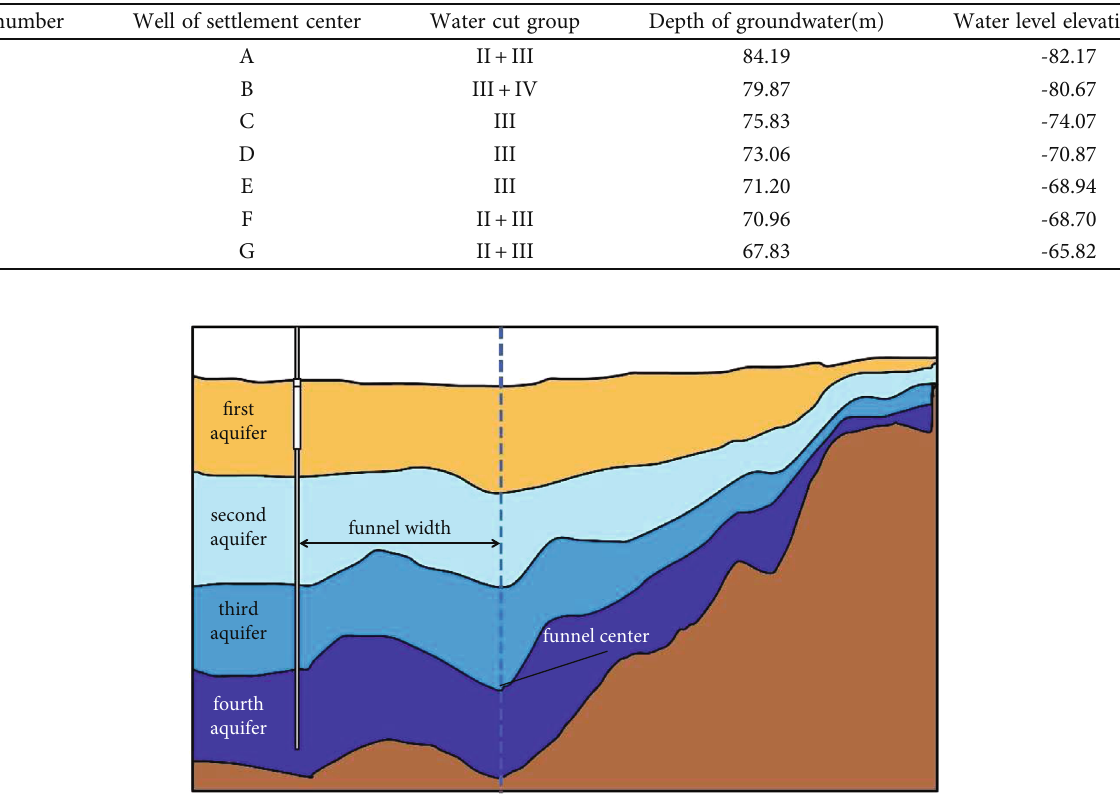
Figure 7: Schematic diagram of hydrogeological model in study area.